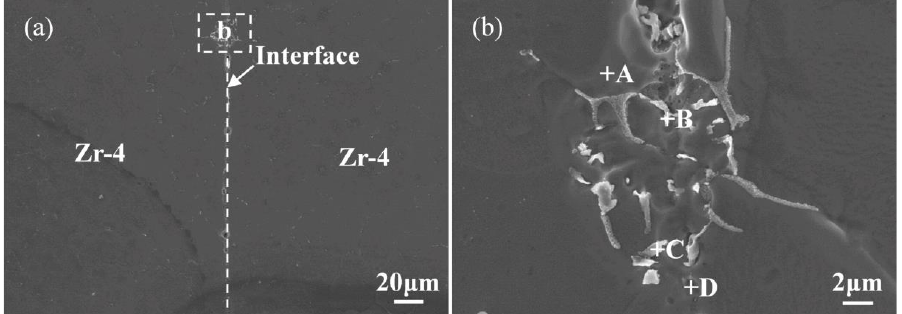
Table 2. Interface bonding ratio of the joints prepared at different bonding temperatures.